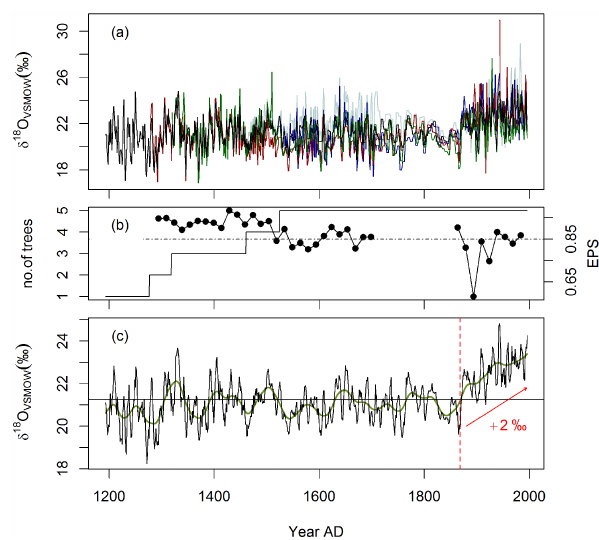
Figure 2. Lhamcoka tree-ring δ 18 O isotope chronology. (a) Indi- vidual δ 18 O time series of five individuals. The coarse resolution between 1707 and 1864 results from shifted block pooling. (b) Run- ning EPS (calculated for 25-year intervals, lagged by 10 years) and number of trees used for the reconstruction (solid line). Dashed line represents the theoretical EPS threshold of 0.85. (c) Tree-ring δ 18 O chronology spanning the period AD1193–1996. Green solid line represents a 50-year smoothing spline. The red dashed line marks the turning point towards heavier isotope ratios after ∼